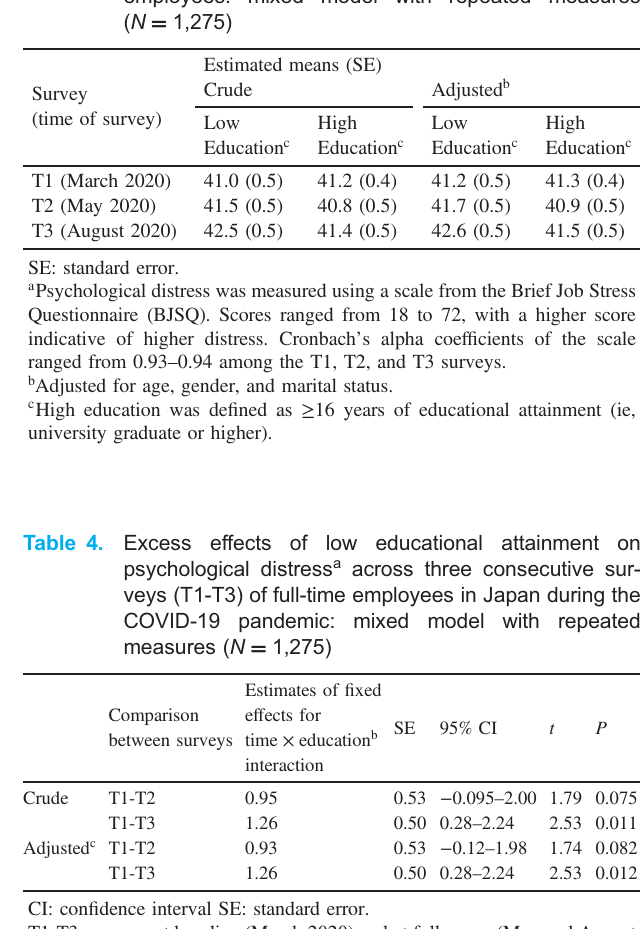
Table 3. Crude and adjusted estimated mean of psychological distress a at baseline (T1), T2 and T3 under the COVID- 19 pandemic among a cohort of Japanese full-time employees: mixed model with repeated